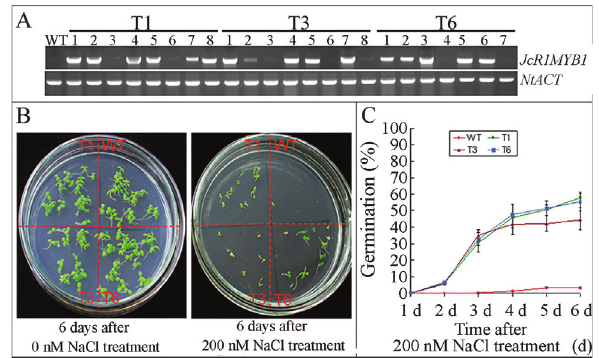
Figure 3 - Characterization of transgenic tobacco plants. (A) Molecular identification of JcR1MYB1 in T 2 transgenic plants (T1, T3, and T6 lines) by RT-PCR. (B) The seed germination of WT and transgenic plants (T1, T3, and T6 lines) on MS containing 200 mM NaCl. (C) The germination rate of WT and transgenic plants (T1, T3, and T6 lines) on MS containing 200 mM NaCl.